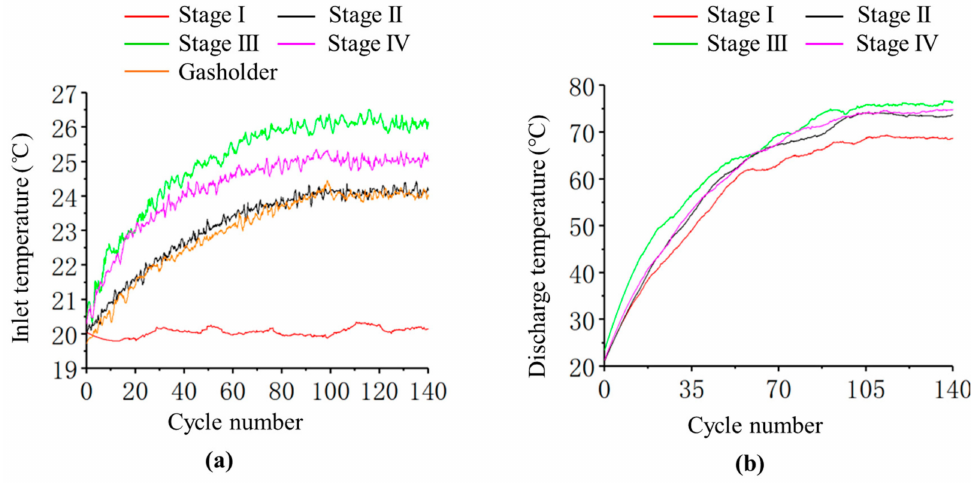
Figure 20. The ( a ) inlet temperature and ( b ) discharge temperature under the high